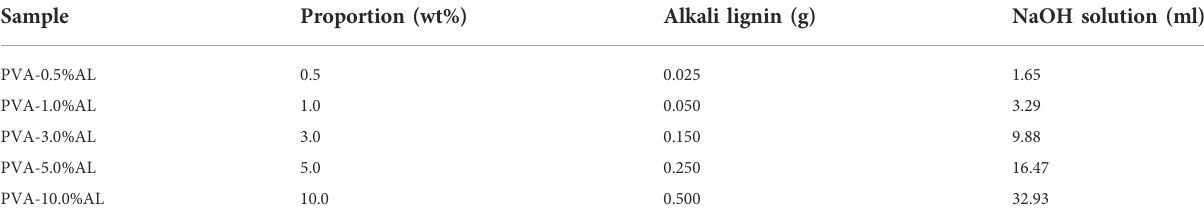
TABLE 2 Preparation parameters of PVA/AL fi lms.